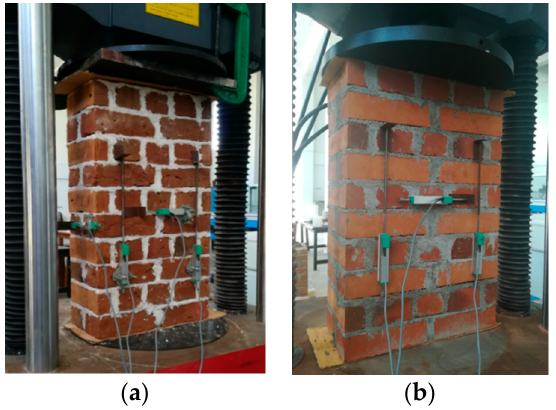
Figure 2. ( a ) Testing of natural hydraulic lime (NHL) mortared wallettes and ( b ) Testing of ordinary Portland cement (CM) mortared wallettes.